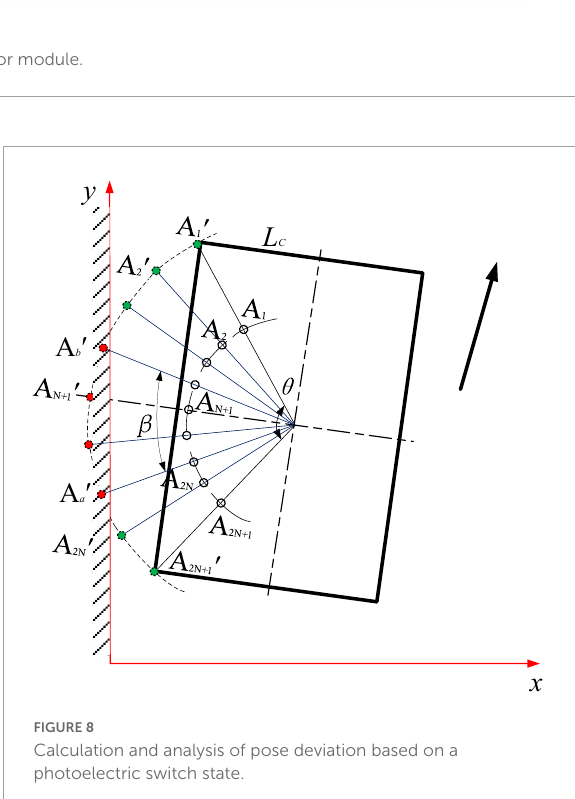
FIGURE7 An autonomous edgewise navigation model of an N (odd) photoelectric switch lateral arc array: (1) A road edge, (2) An ideal target band, (3) A detection arc, (4) An autonomous mobile platform, (5) A transverse centerline.